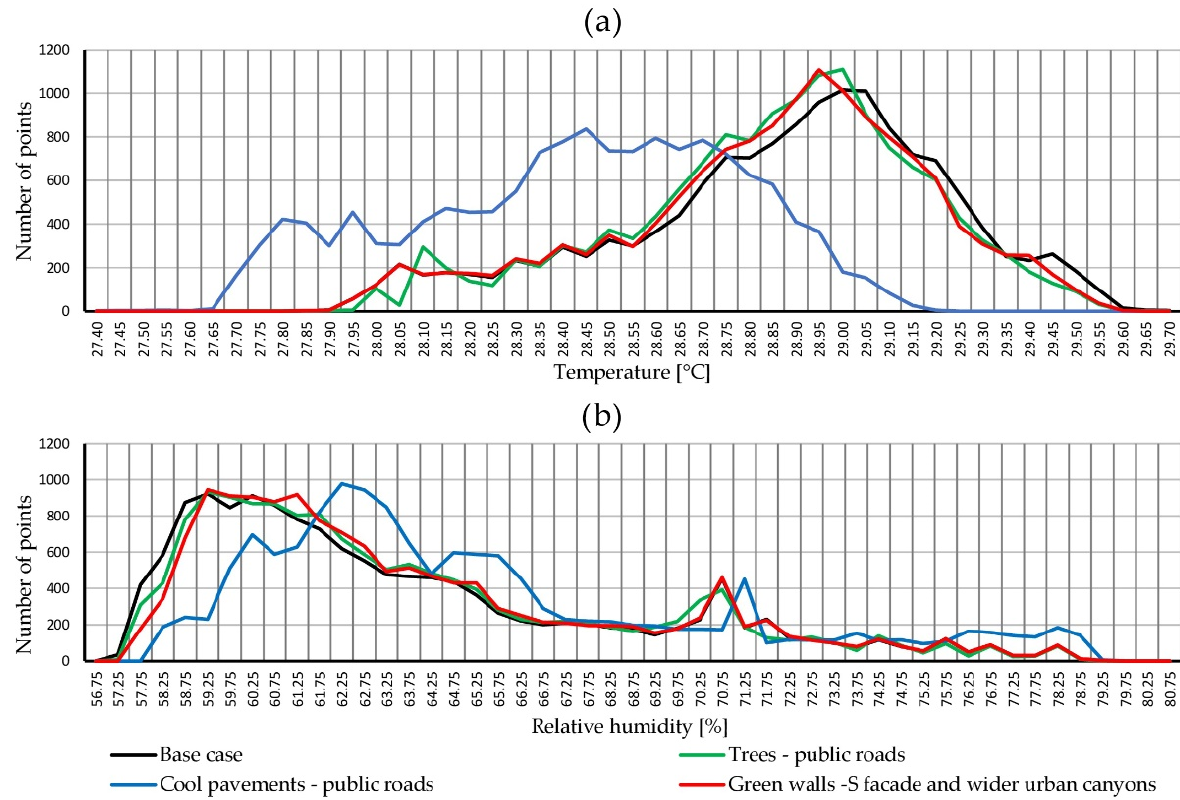
Figure 5. Distribution of the points in the M1 model related to the external air temperature ( a ) (°C) and the relative humidity ( b ) (%) considering the base case, two configurations for the urban retrofitting with trees, cool pavements and green walls.